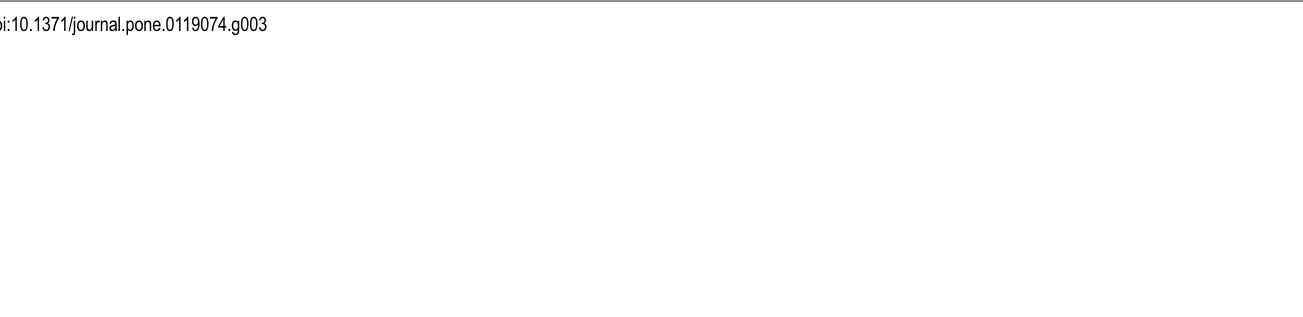
Fig 3. How to find the required number of clusters ( ^ C ). First, for a given set of parameters, θ i , hypothesis test simulations are run for each level of C A . Second, the results of the simulations are averaged into one point per level. Third, ^ C is calculated by interpolating a point at ^ P = 0.8 between ( C 0.8 − , ^ P 0.8 − ) and ( C 0.8 + , ^ P 0.8 + )